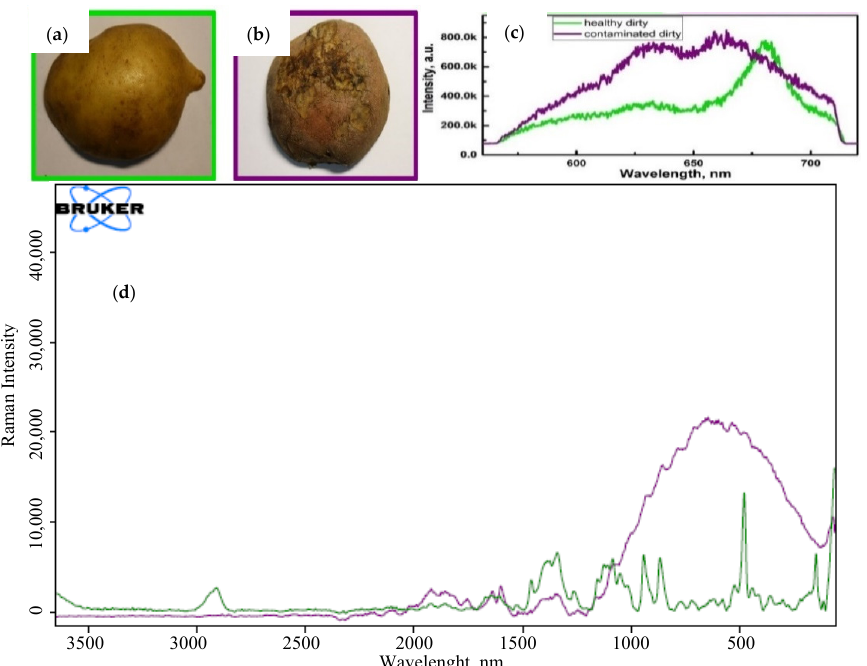
Figure 8. Example of sampling points of the marketable ( a ) and sorted-out ( b ) potato tubers. Normalized (averaging five spectra) fluorescence and RAMAN ( d ) spectra of the marketable and sorted-out potato tubers of the Kumach, Udacha, and Zhukovsky varieties, respectively ( c ). The spectrum from the entire surface of the potato tubers was averaged. The spectra are quite different from each other. The potato tubers were then thoroughly washed of dust and soil residues without compared to assess the contribution of dust and soil to the overall spectrum (Figure 9).